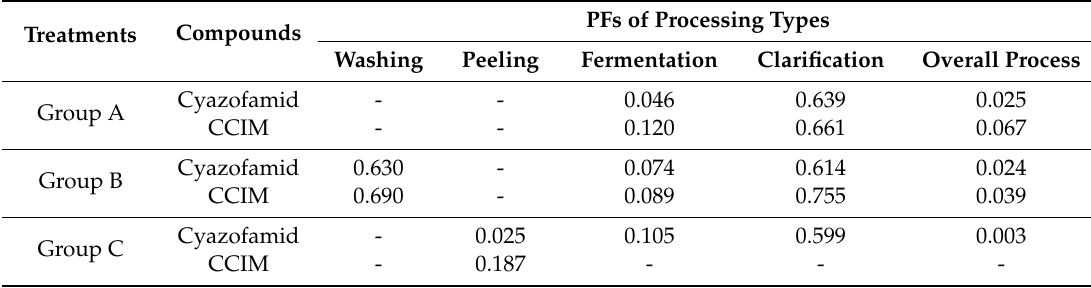
Table 3. PFs for di ff erent processing procedures of cyazofamid and CCIM ( n = 3).